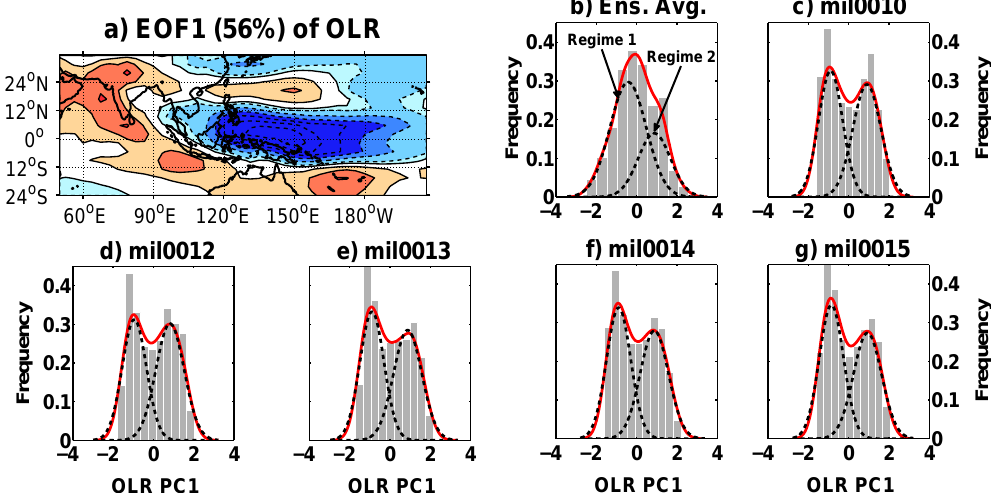
Figure 6. Regime behaviour in ECHAM5/MPIOM model simulations. (a) Dominant OLR pattern (EOF1). Positive (negative) contours are shown by solid (dotted) lines. (b) PDF estimate of PC1 of OLR (red solid line) and each regime (dashed lines) for ensemble average and (c–g) for each of the experiments separately. Table 1. Correlation coefficients between the MCA1 time series, Niño indices and reconstructed global temperatures from Shi et al. (2013). Bold numbers indicate the largest value in each row. Numbers in parentheses indicate the statistical significance levels. NS stands for not significant. MCA1 of Niño 3.4 Niño 1 +